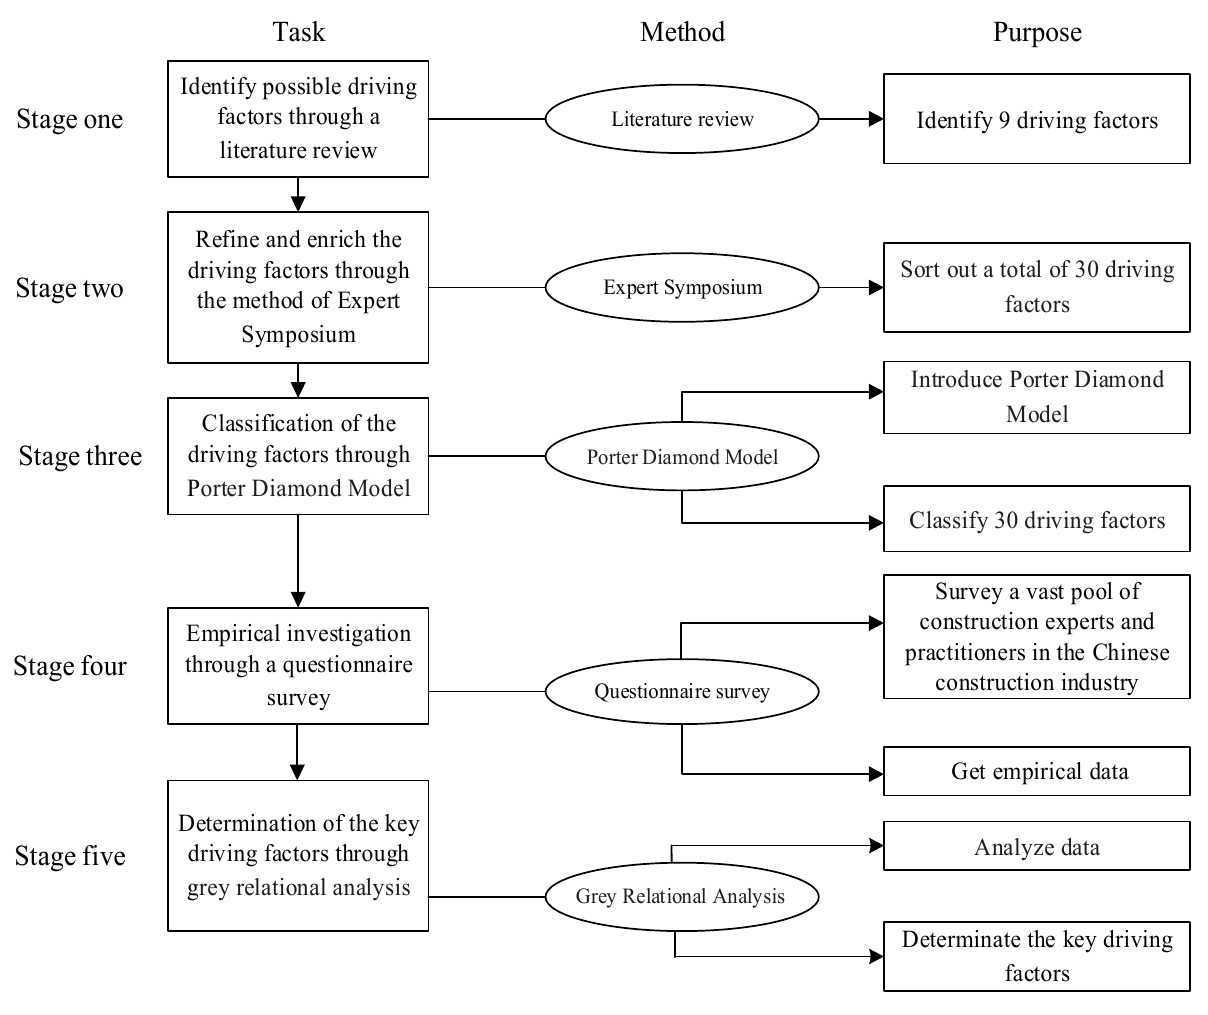
Figure 1. Five-stage research protocol.